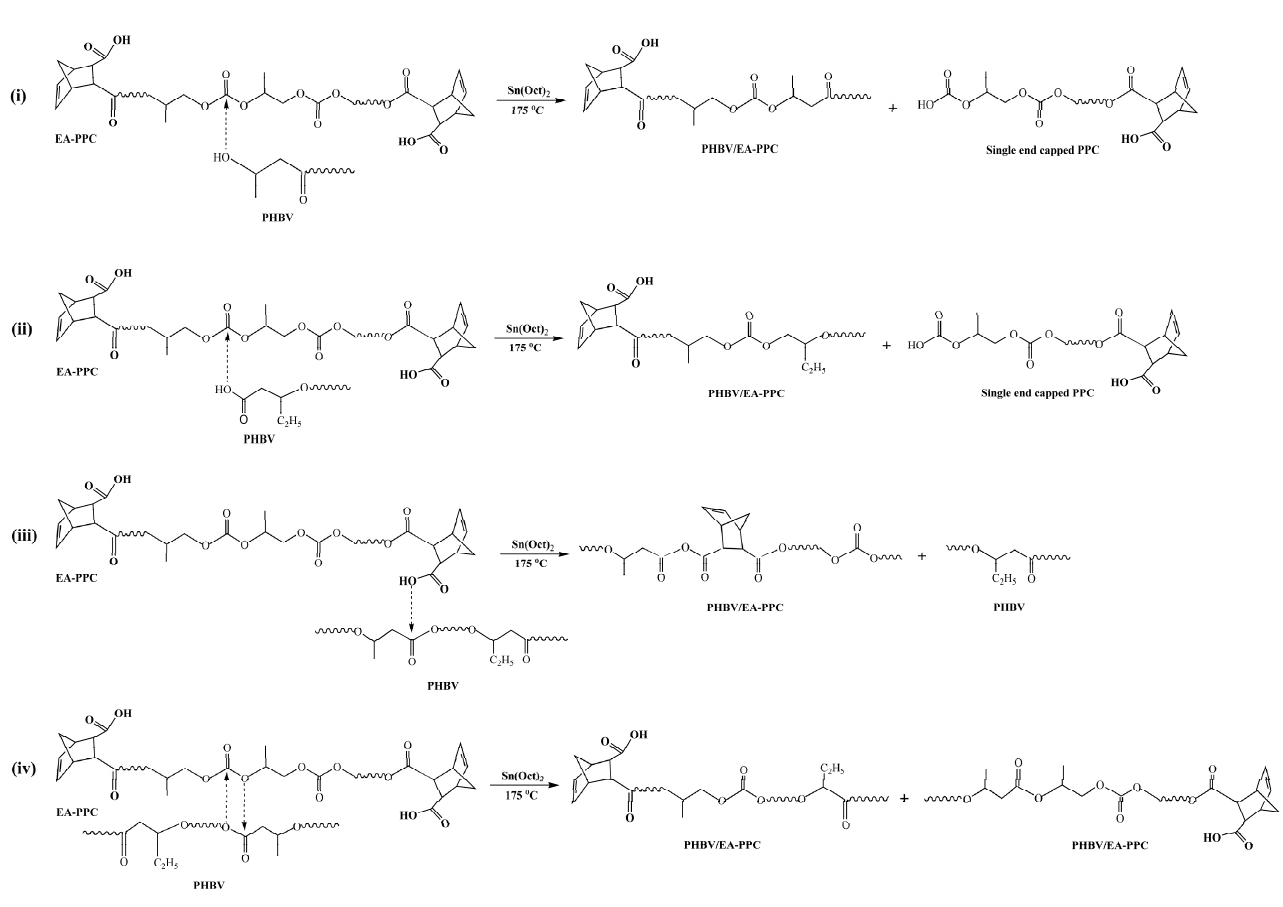
Figure 6. Formation mechanism of PHBV/EA–PPC blends. ( i ) terminal hydroxyl group of PHBV attacked carbonyl carbon of EA–PPC, ( ii ) terminal carboxyl group of PHBV attacked carbonyl carbon of EA–PPC, ( iii ) terminal carboxyl group of EA–PPC attacked carbonyl carbon of PHBV, ( iv ) direct transesterification.